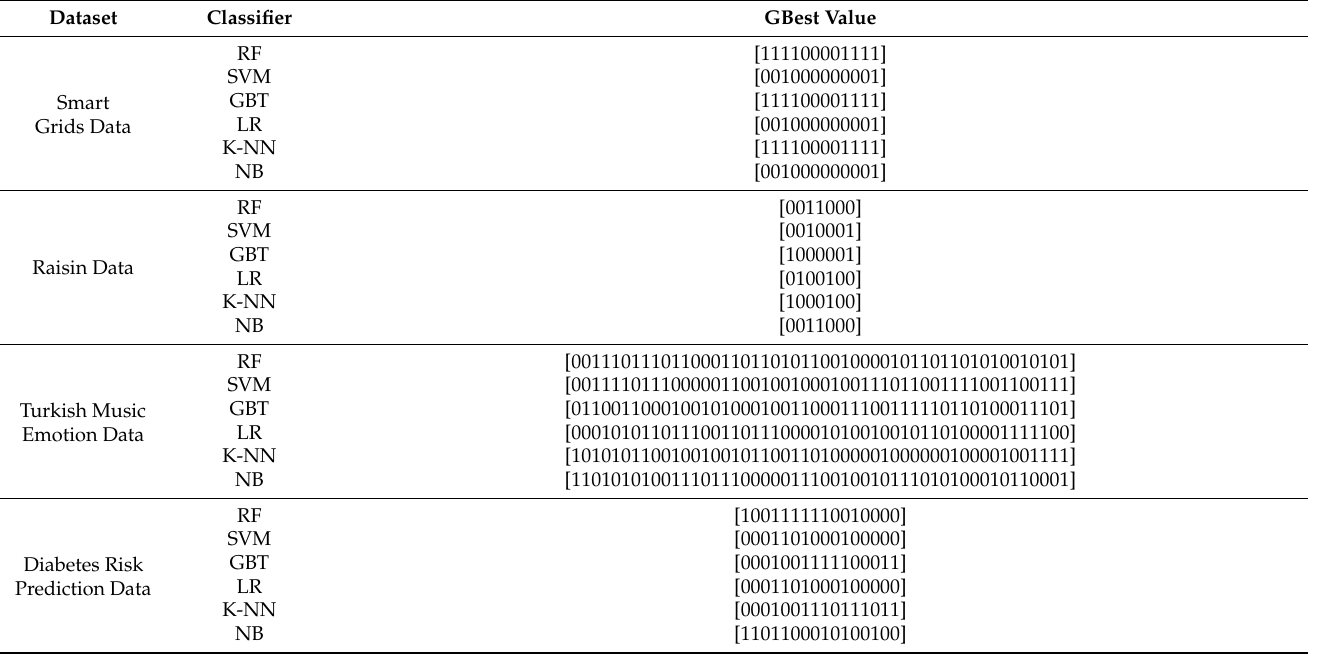
Table 14. BCSA GBest Values Results